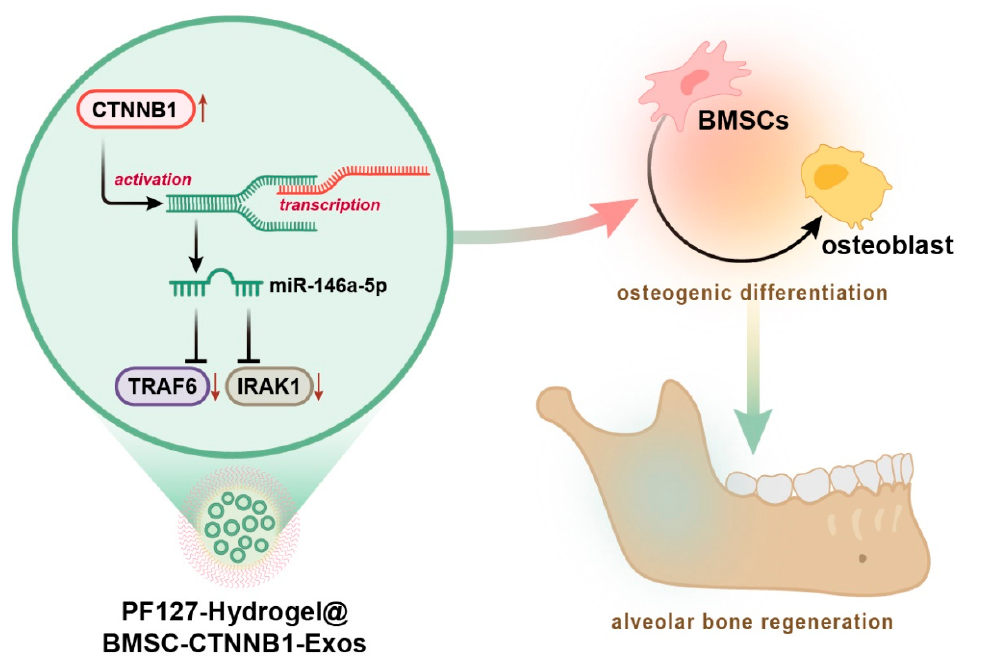
Figure 1. Molecular mechanism graph delineating the role of directed differentiation of BMSCs induced by BMSC-CTNNB1-Exos-loaded PF127 hydrogel in alveolar bone regeneration. CTNNB1 targets and inhibits IRAK1 and TRAF6 expression by activating the transcription of miR-146a-5p. PF127 hydrogel-loaded BMSC-CTNNB1-Exos promote osteogenic differentiation of BMSCs and alveolar bone regeneration, thereby facilitating repair of alveolar bone defects in rats.